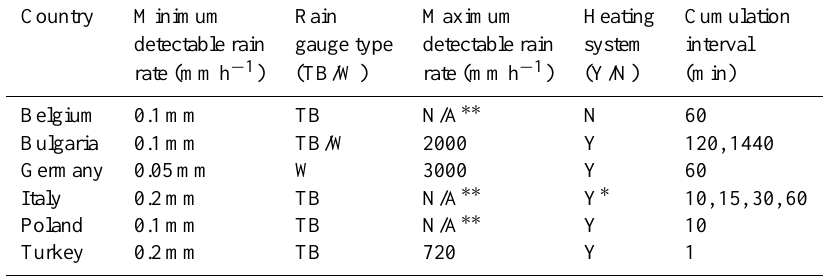
Table 2. Summary of the rain gauge characteristics. Two rain gauge types are present: tipping bucket (TP) and weighting (W). Country Minimum Rain Maximum Heating Cumulation detectable rain gauge type detectable rain system interval